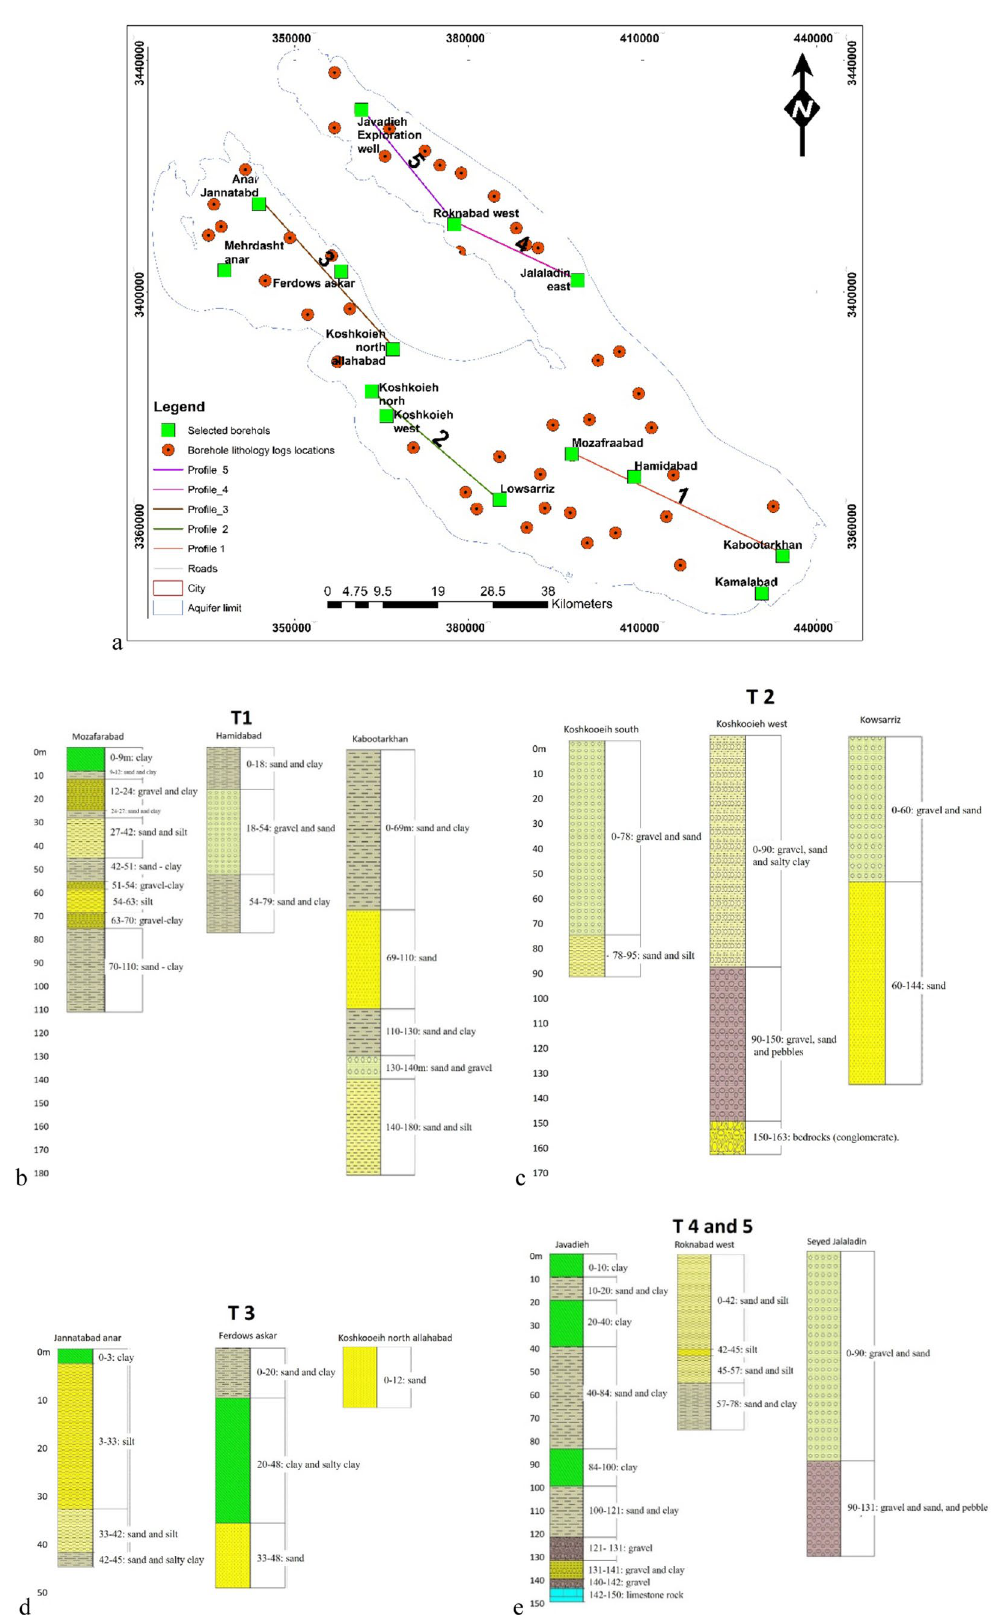
Fig. 4 a Location of selected boreholes in the study area, b – e geological logs of selected wells in the study